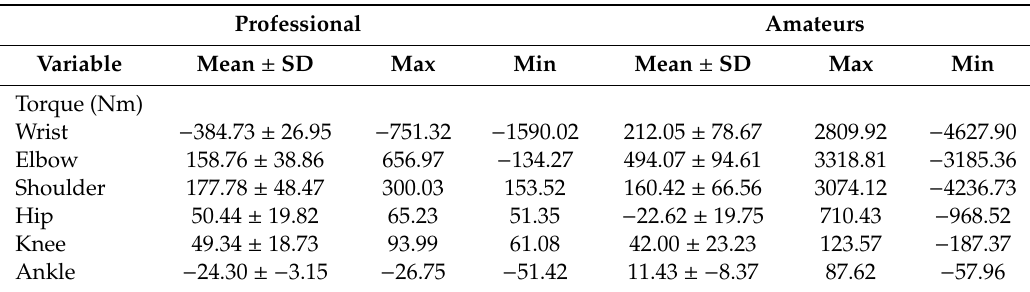
Table 2. The meanSD, maximum and minimum value of professional and amateur parachutists at the event of foot